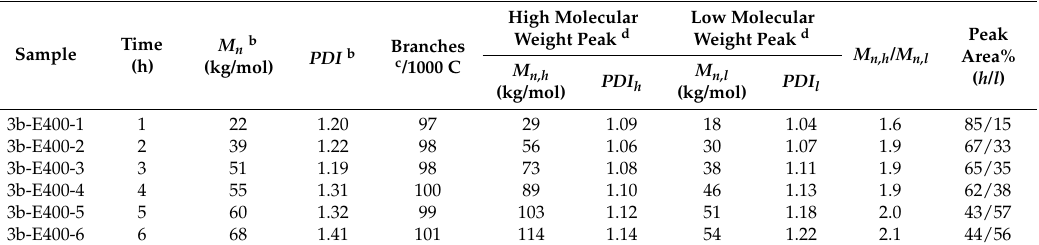
Table 3. Ethylene polymerization using 3b at 5 ◦ C and 400 psi in chlorobenzene a .